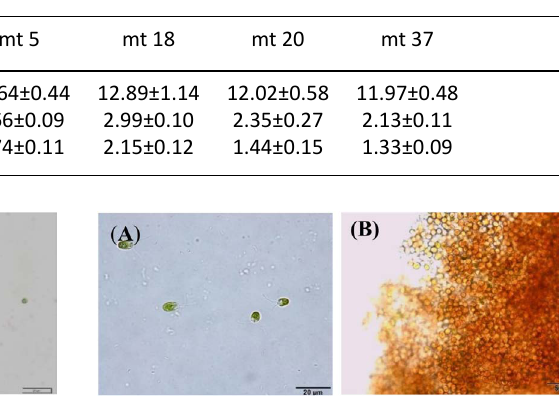
Fig. 2. D. salina KU 11 cells grown in liquid modified Johnson’s medium containing 2.5 M NaCl at 3 rd day (A) and 12 th day (B) of incubation, observed under microscope.